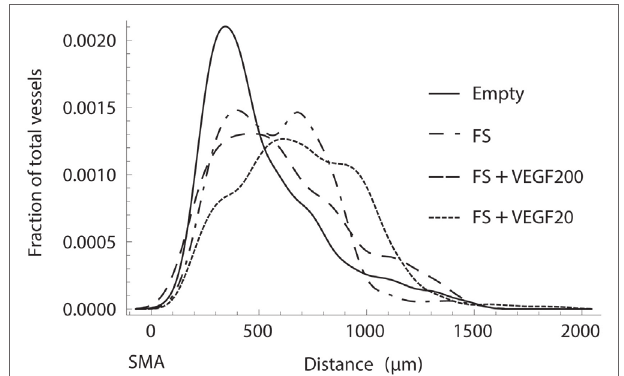
FIGURe 8 | Normalized histogram of the transversal ingrowth distance of vessels into the scaffold as a fraction of the total vessels count. Fibrin with 20 ng of recombinant human vascular endothelial growth factor (rhVEGF165) resulted in the strongest ingrowth while it was severely limited in the absence of a fibrin